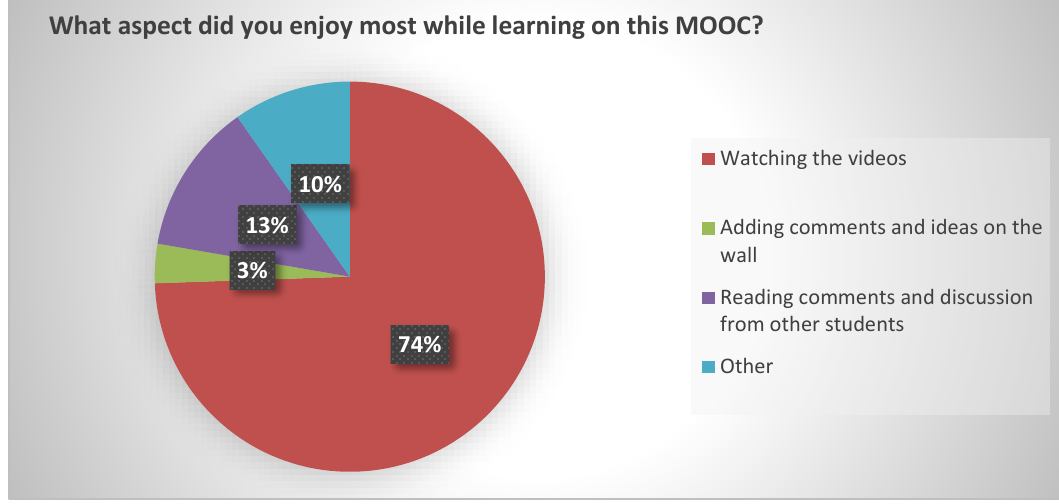
Figure 5. Percentages of students’ responses concerning their preferred learning styles.